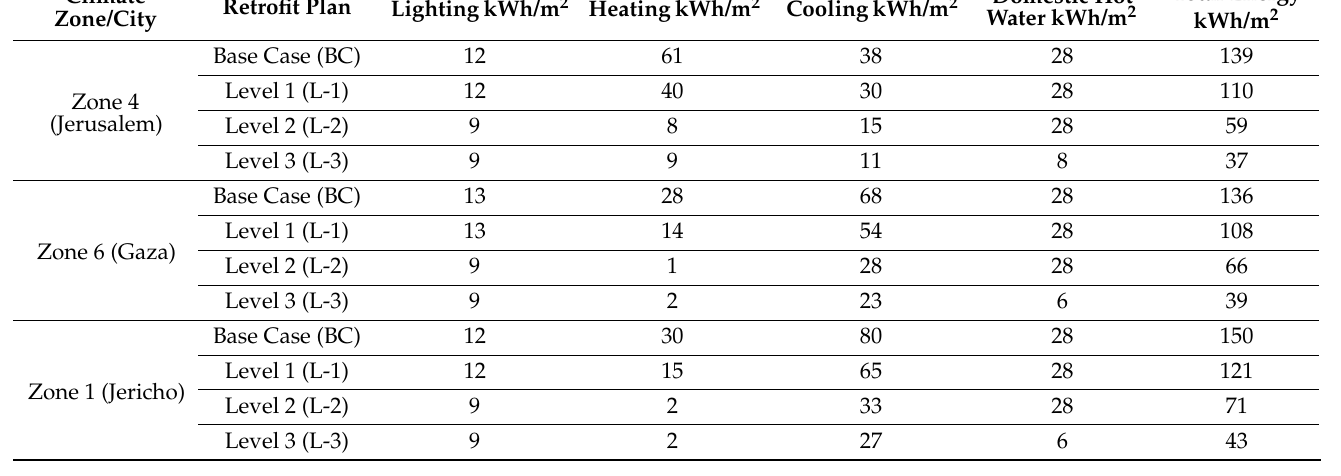
Table 1. Results from the simulation for energy consumption for lighting, heating, cooling, and domestic hot water, com- paring the base case scenario with the three-level retrofit plans for buildings with two units per floor area. Climate Zone/City Retrofit Plan